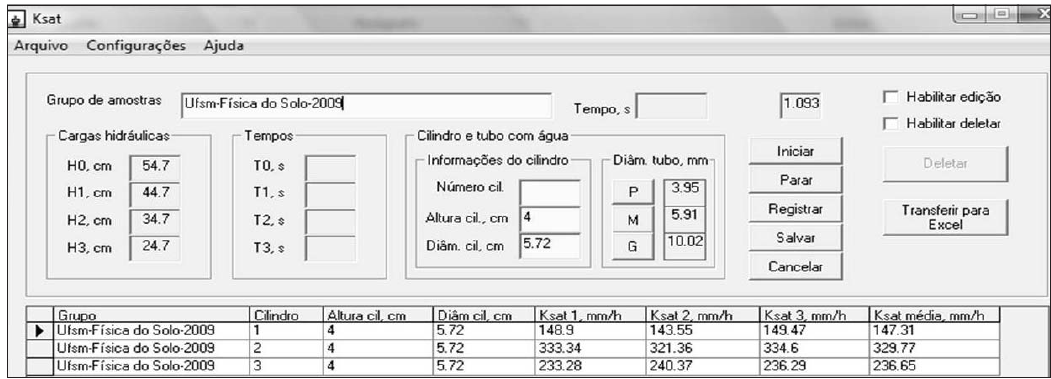
Figura 2. Tela principal do Ksat.